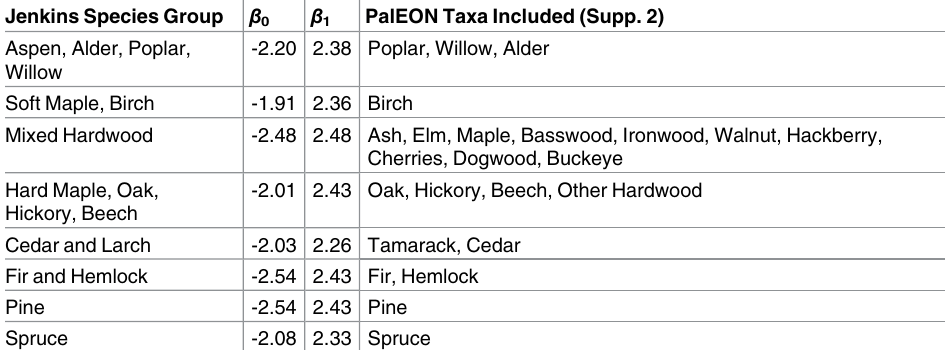
Table 1. Biomass parameters used for the calculation of biomass in the pre-settlement dataset (rounded for clarity). Jenkins Species Group β 0 β 1 PalEON Taxa Included (Supp.